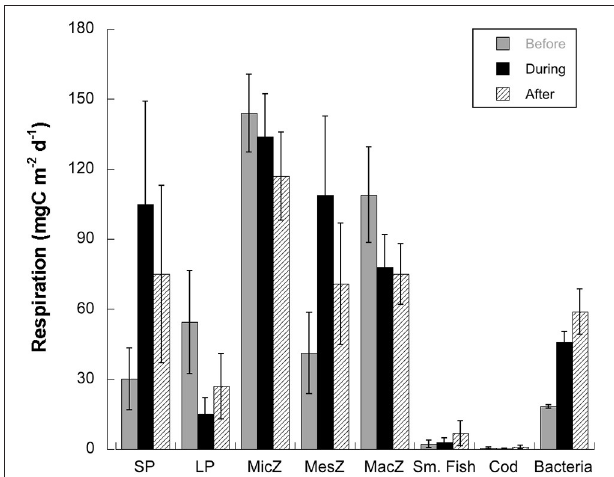
FIGURE 6 | Respiration rates of the main food web compartments, predicted by the inverse modeling, during three time periods in the Fram Strait, before, during, and after the warm water event of 2005–2007. Compartment identification as in Figure 2